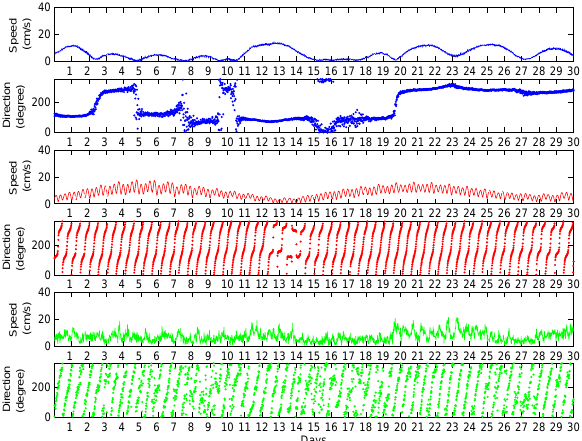
Fig. 6. From top to bottom speed (cms − 1 ) and direction (degrees) of mean-residual, tidal and surge components at location NB, 573m depth (from 12 October 1997 to 10 November